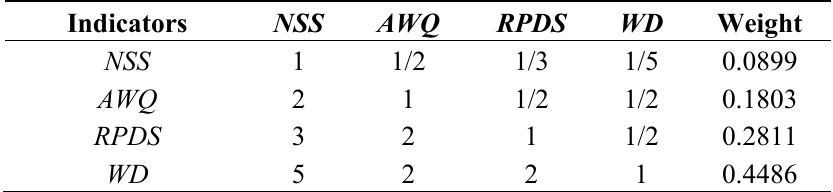
Table A2. The pair-wise comparison matrix for indicators of input.